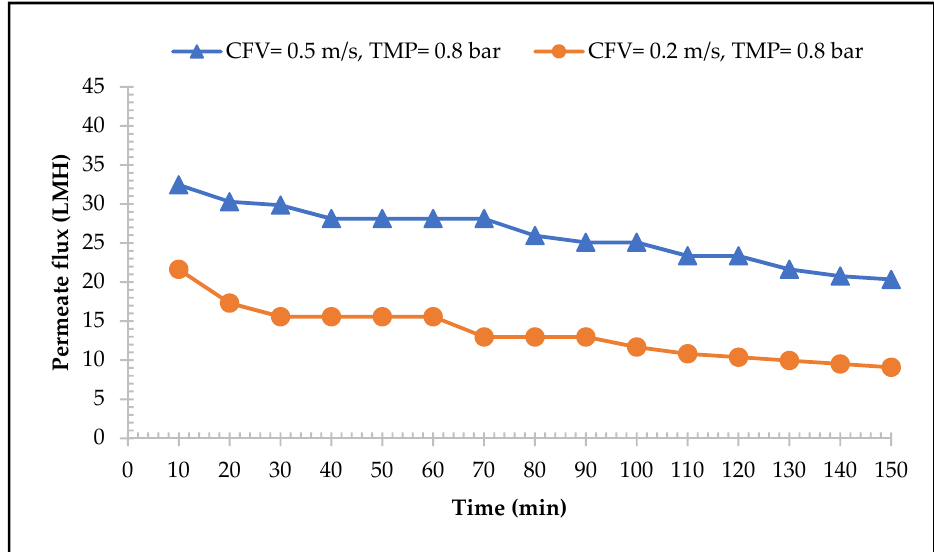
Figure 3. The permeate flux of 0.2 µ m MF membranes with the function of time with different CFVs and constant TMP .